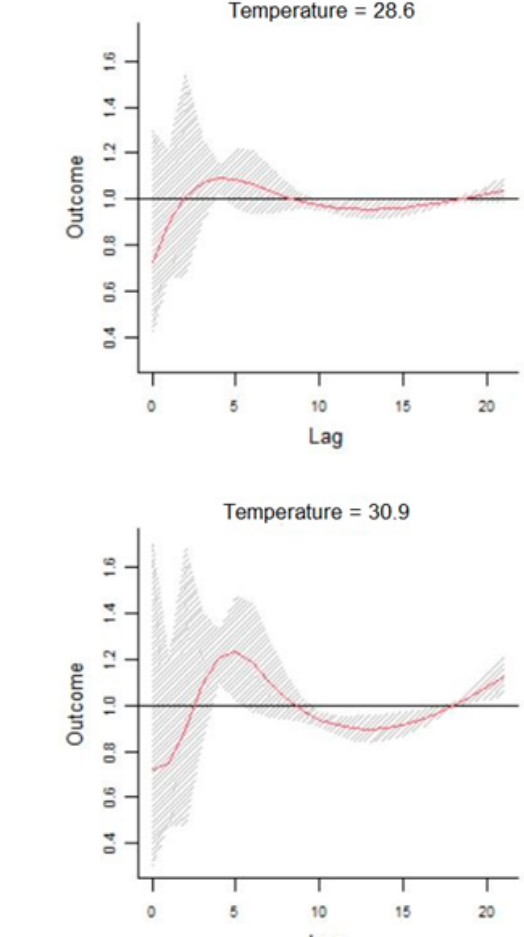
13 of 17 Figure 8. Contour plot of RR of CVD hospital admissions along temperature and lags with references of 20 °C.